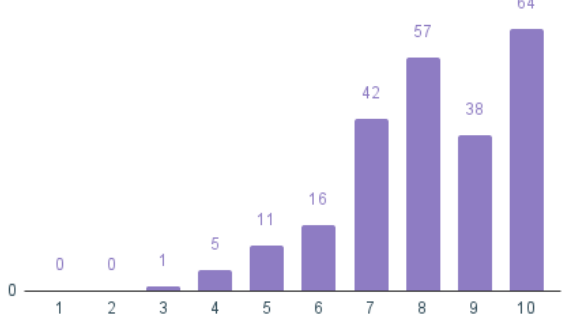
Figure 25. From 0 to 10 how would you rate the game? - Test 1.